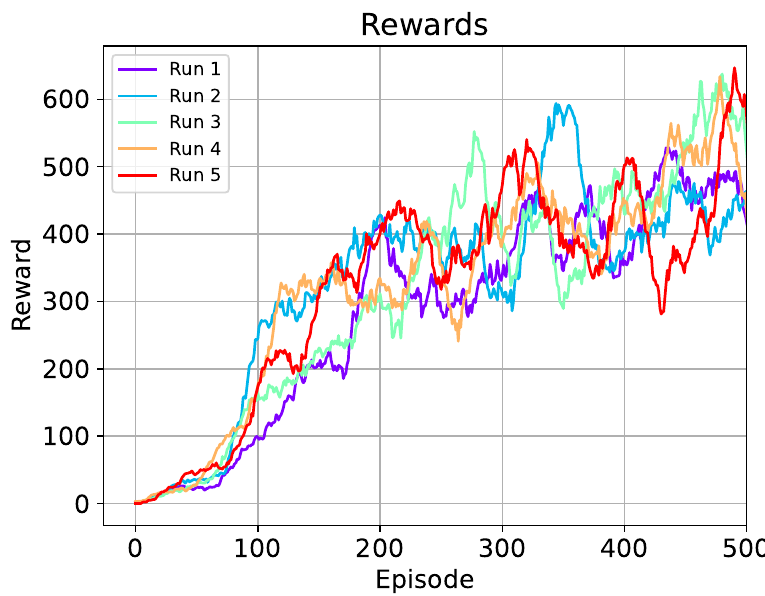
Figure 5. Total reward for five runs using the DQN algorithm during 500 episodes. In the figure, the collected rewards are smoothed in a window of 30 data using a linear